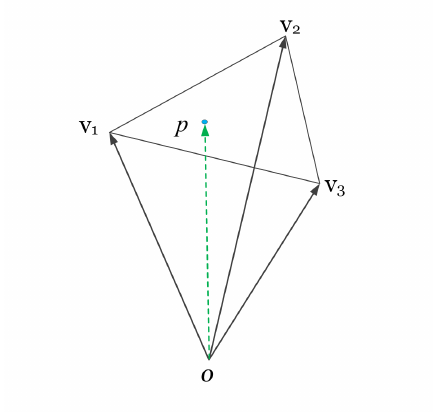
Figure 5: Assigning eigenvectors onto a triangular surface of an